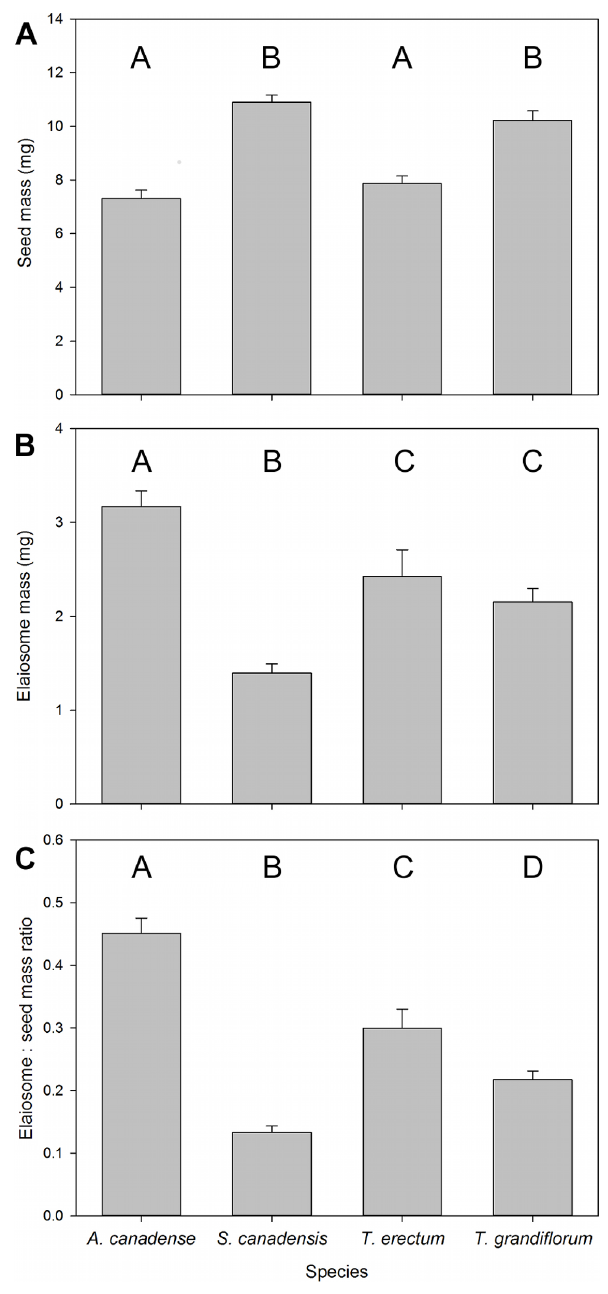
Figure 2. Sizes of diaspores presented to ants. Mean ( 6 SE) a) seed mass, b) elaiosome mass, and c) ratio of elaiosome to seed mass for seeds collected by ants in removal trials. Different letters indicate statistically significant differences (Tukey-adjusted p # 0.05). were larger at the start of treatments (i.e. those that had fewer of the initial 50 workers die) also had greater masses of brood (X 2 = 8.85, df= 1, p =0.003). Colonies provided with S. canadensis diaspores had a significantly greater brood mass than those provided with T. grandiflorum (Tukey-adjusted p =0.002) and marginally significantly more than those in the control treatment (Tukey-adjusted p= 0.093). Colonies in the A. canadense treatment also had marginally greater brood masses than those in the S.